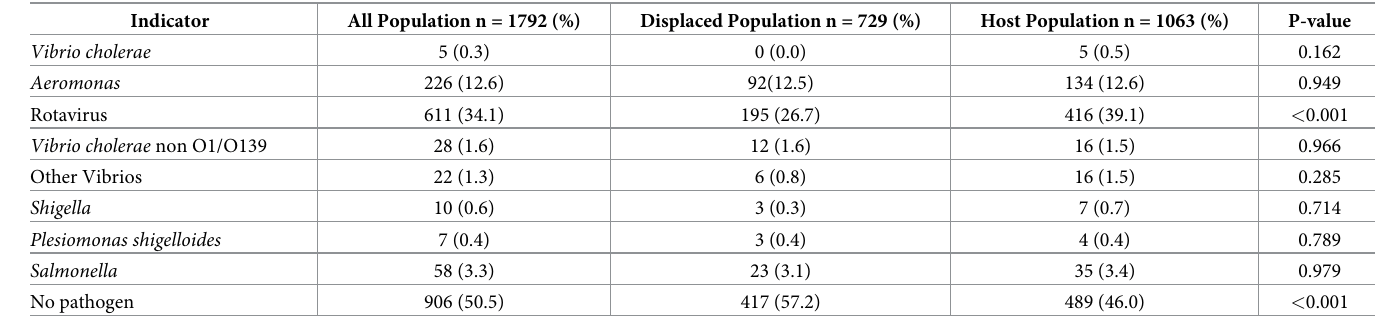
Table 5. Detection of enteric pathogens in the fecal specimen of diarrhea patients presenting to DTCs � , April—December 2018, Cox’s Bazar, Bangladesh.